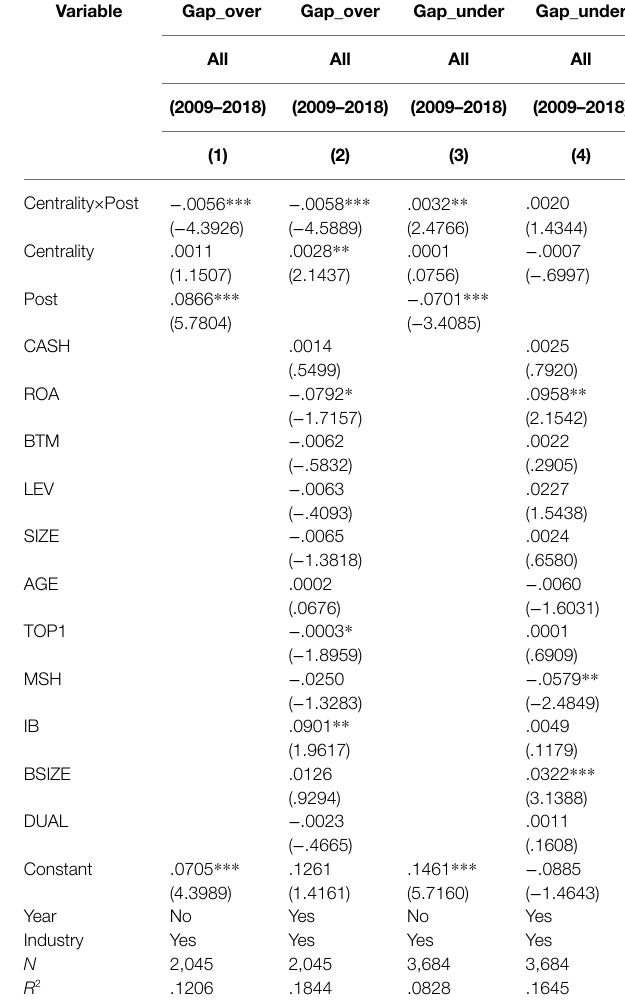
TABLE 10 | Mechanism effect of foreign investors.